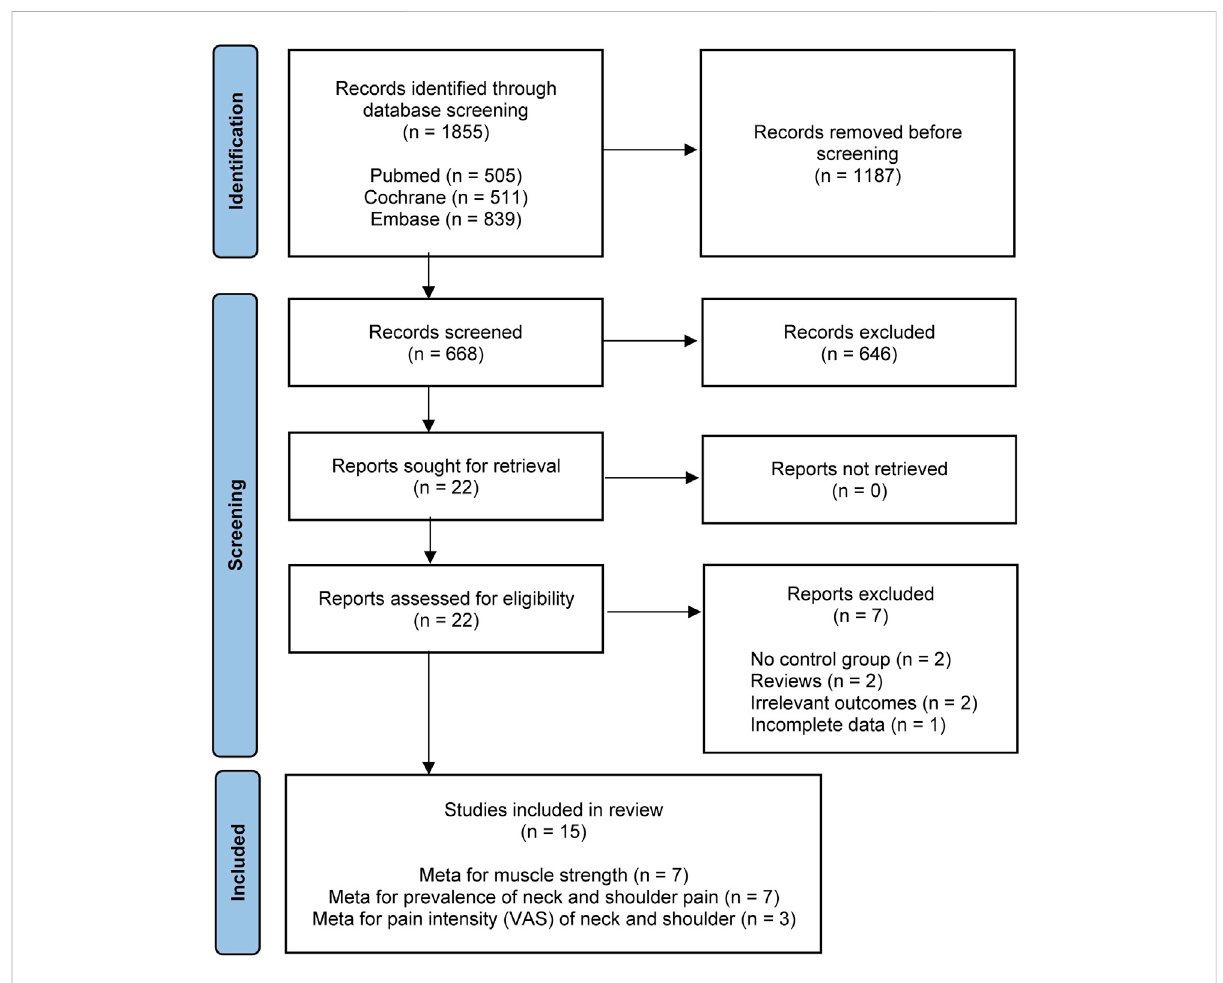
FIGURE 1 PRISMA fl owchart of the study selection process for the